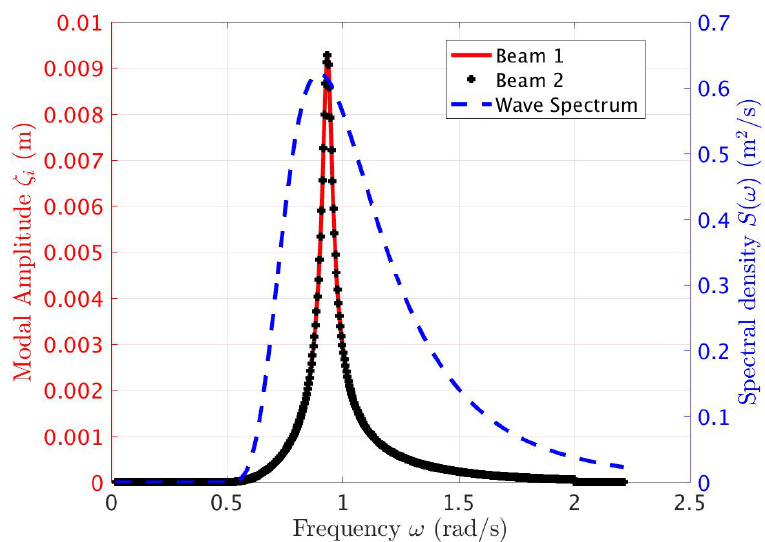
Figure 6. Fundamental modes of beam flexural deflection amplitude response to an irregular wave spectrum (Pierson–Moskowitz, H s = 1.0 m, T e = 5.0 s) with beams fitting tightly within their deck supports. Also shown is the power spectral density.